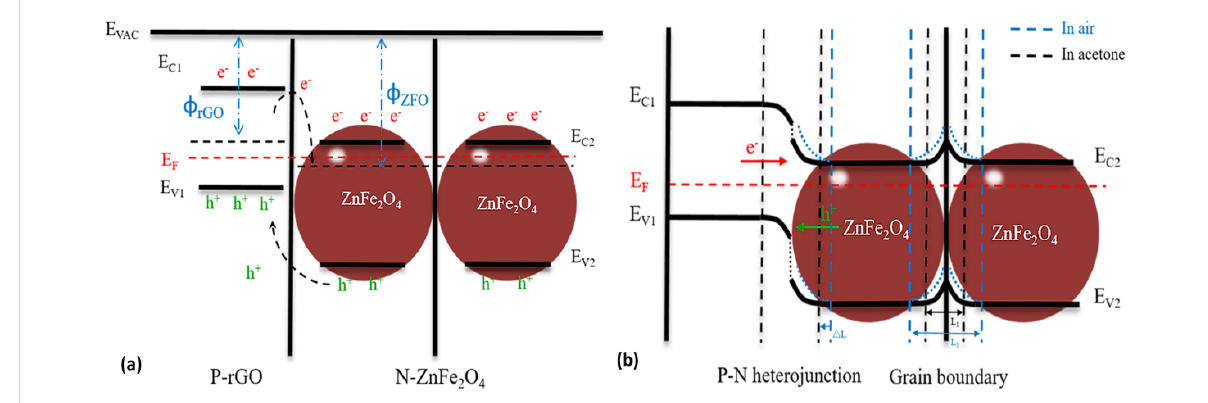
Figure 11: Schematic of the proposed acetone sensing mechanism of ZnFe 2 O 4 /rGO. Band diagram of rGO and ZnFe 2 O 4 (a) at equilibrium condition (b) in air and in